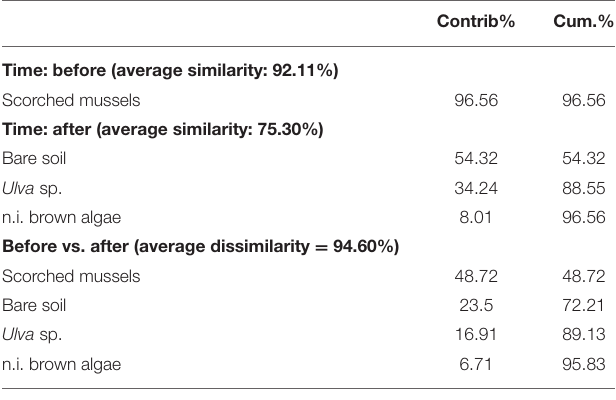
TABLE 1 | SIMPER routine results showing taxa with the greatest contributions to similarity among sites and the dissimilarities between times.